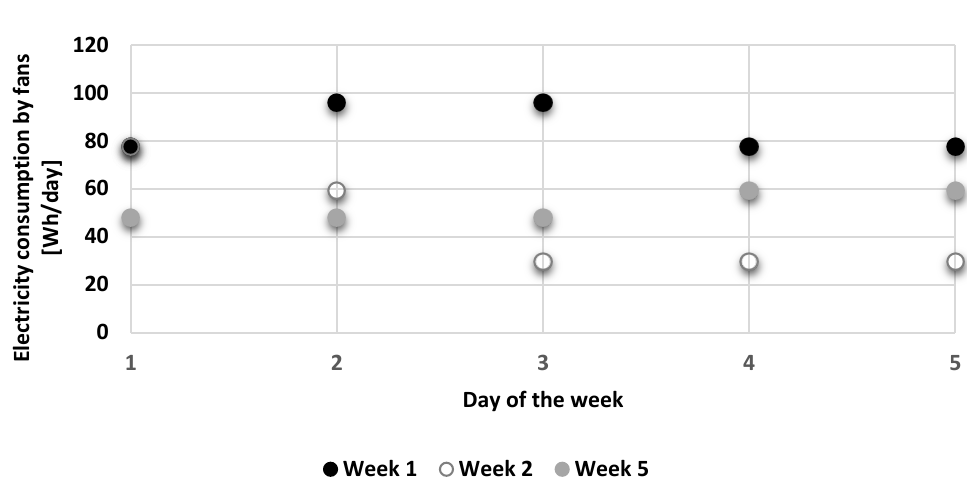
Figure 6. Weekly work of ventilation based on usage profile (three selected weeks).